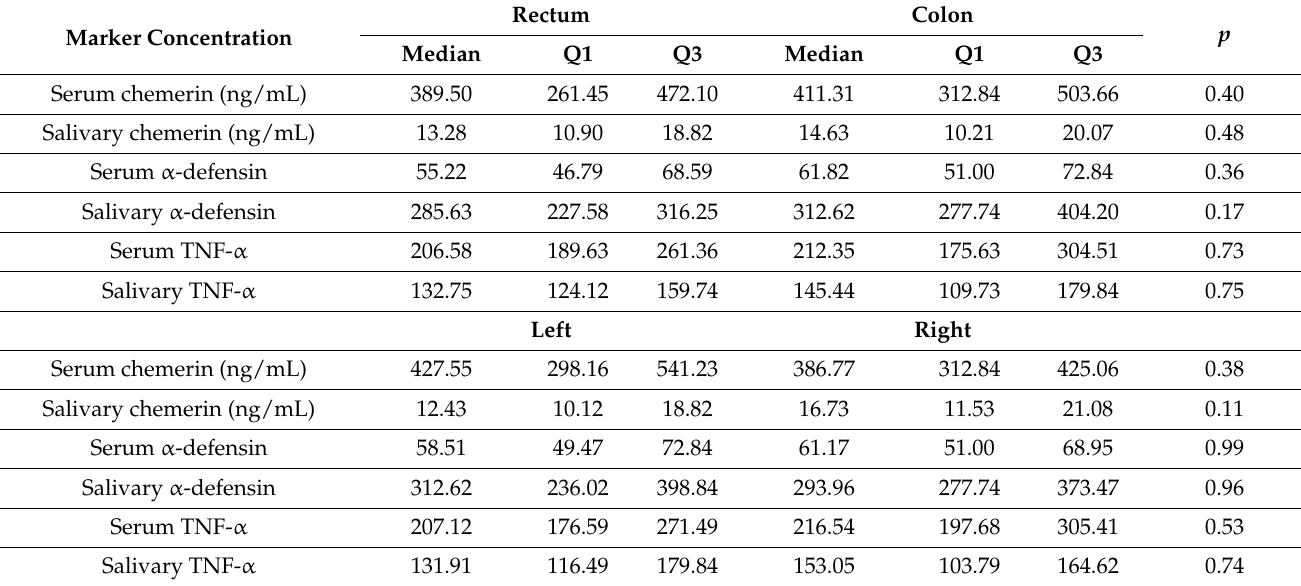
Table 6. Serum and salivary concentrations of chemerin, α -defensin 1 and TNF- α depending on the tumor location.